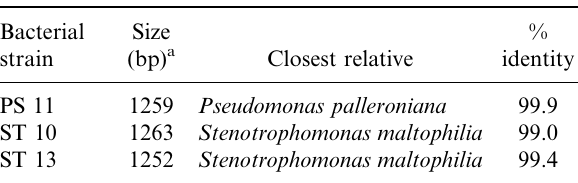
Table 2. Sequencing results of bacterial strains used for inoculum